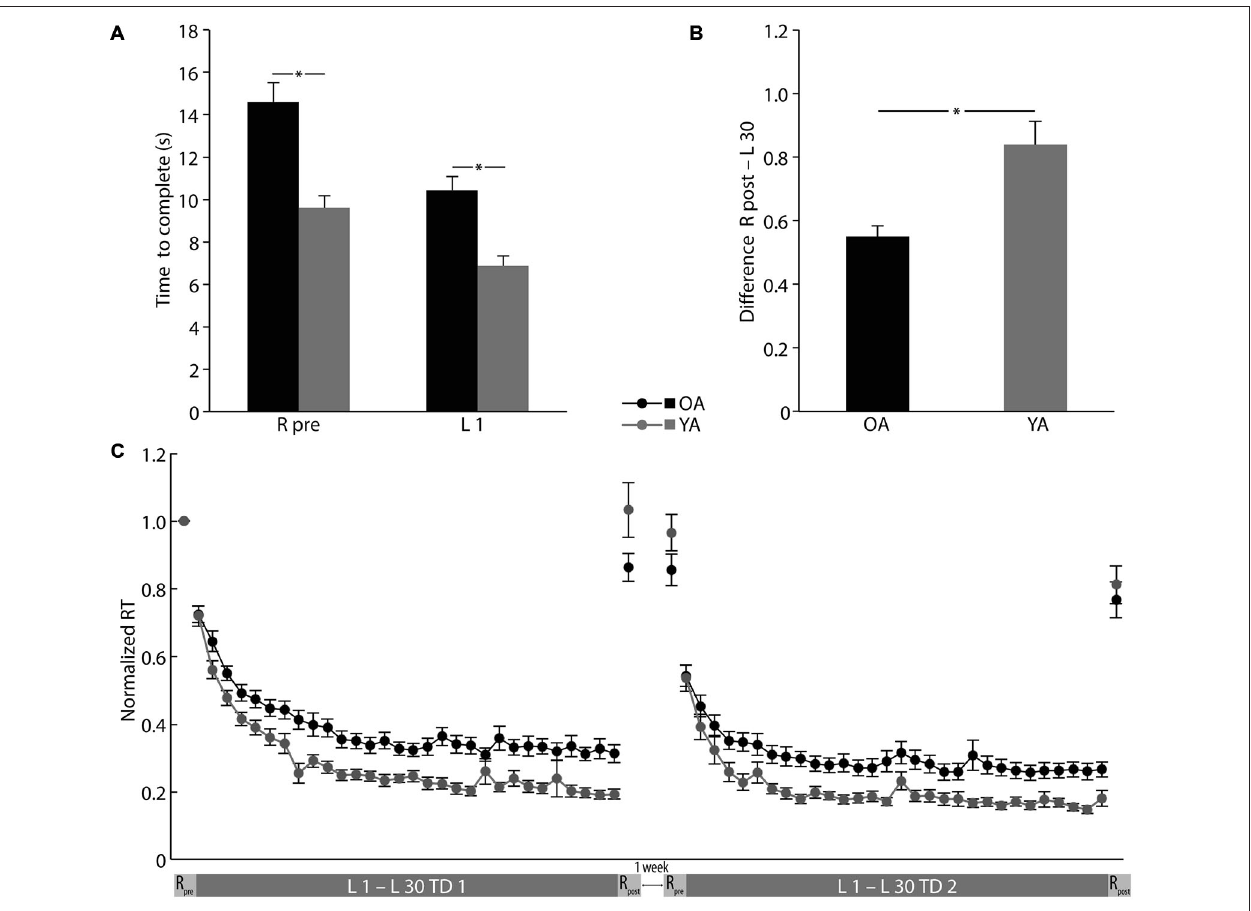
FIGURE 2 | Global and sequence specific B-SRTT learning. (A) Initial B-SRTT performance differences between younger (YA) and older (OA) adults. (B) Sequence-specific B-SRTT performance on training day (TD) 1. (C) B-SRTT performance for TD1 and TD2 (separated by at least 1 week). For details see